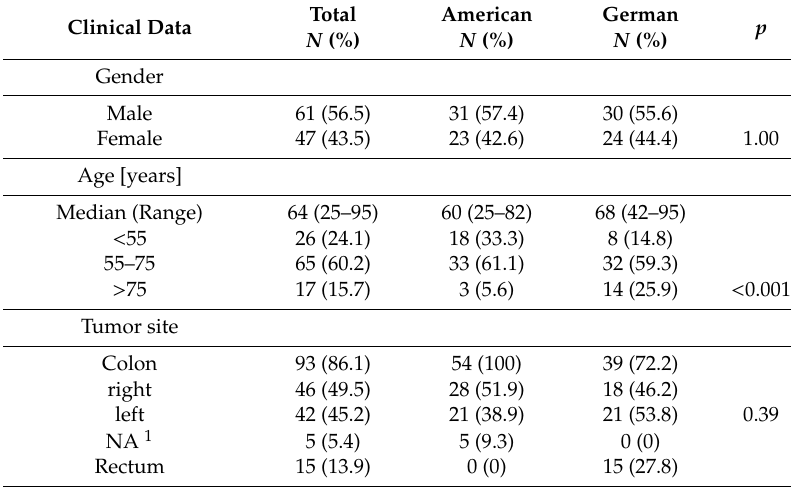
Table 1. Summary of clinical metadata and mutational classification, according to Schell et al.